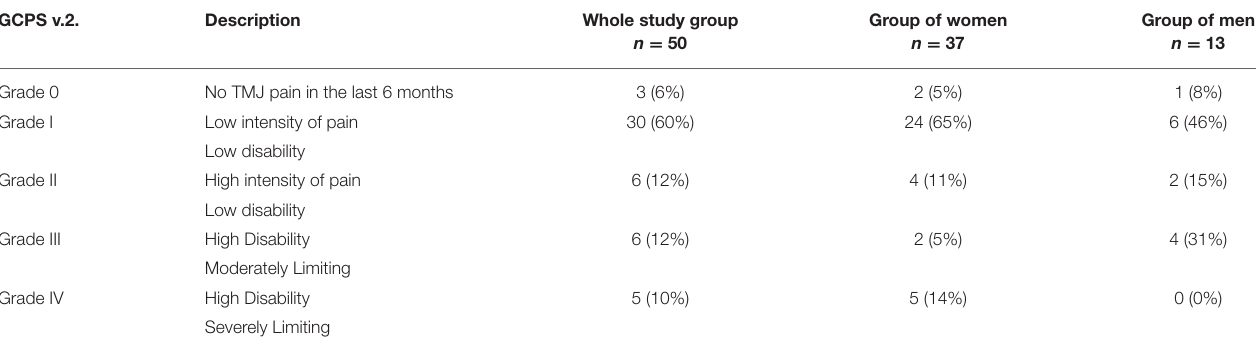
TABLE 2 | Graded Chronic Pain Scale